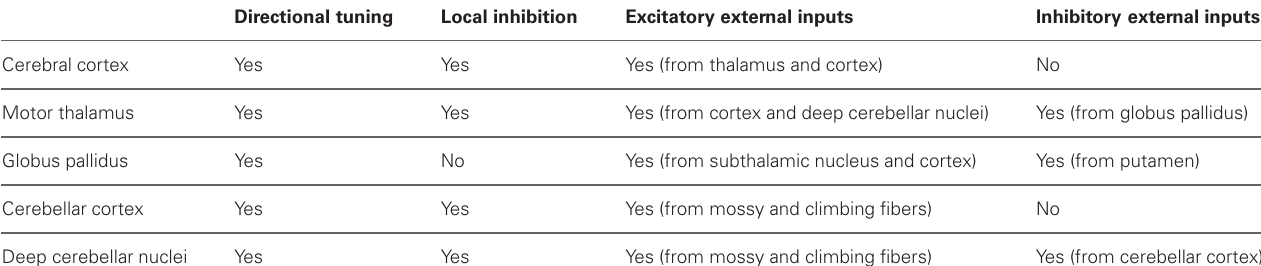
Table 1 | Summary of synaptic inputs to areas with known motor directional